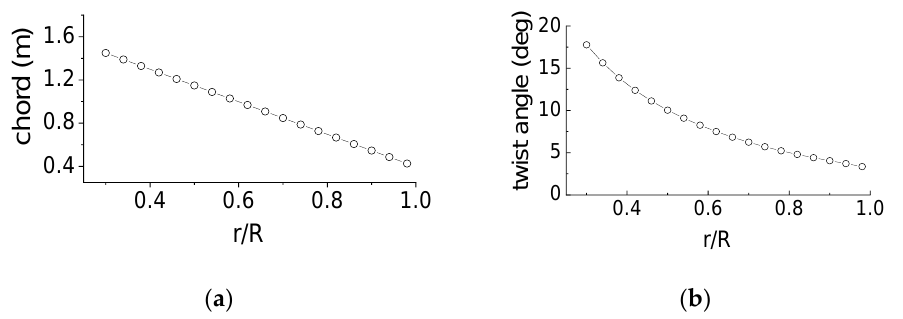
Figure 2. Geometric parameters of the blades: ( a ) chord; ( b ) twist angle.